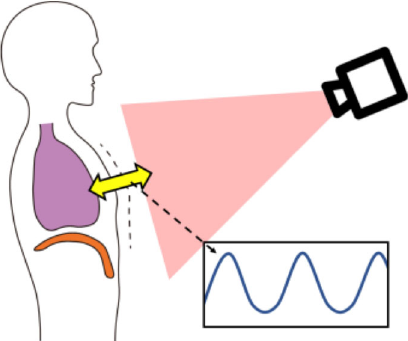
Figure 1. Principle of motion-based respiration measurement.